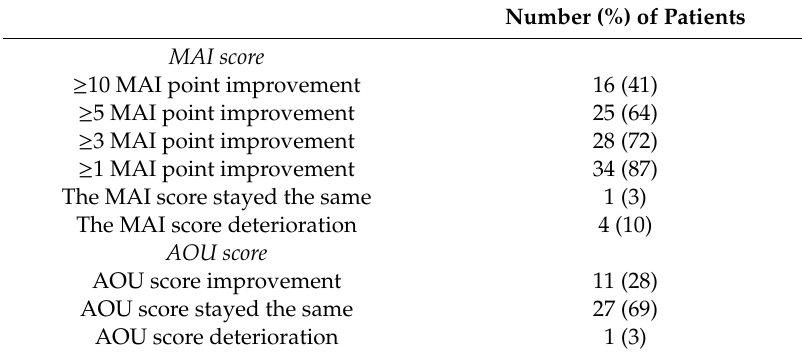
Table 2. Changes in Medication Appropriateness (MAI) and Assessment of Underutilization Index (AOU) score between admission and 30 days after discharge ( n = 39).